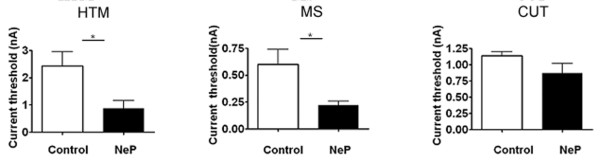
Comparison of the activation threshold of Aβ-fiber neurons in response to intracellular current injection, between control and neuropathic (NeP) rats. The current threshold was defined as the minimum current required to evoke an AP by intracellular current injection. Excitability of the DRG somata was significantly increased, as indicated by the decreased activation threshold in MS and HTM neurons. CUT, cutaneous neurons, include Aβ-fiber LTM GF, RA, and SA neurons. Asterisks above the graph indicate the significant difference between control and neuropathic animals: *p < 0.05. Unpaired t-test.